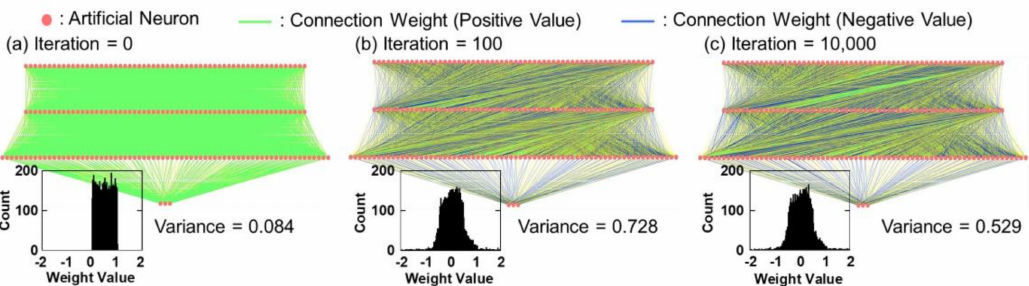
Figure 7. Neural interpretation diagram of TDNN model ( a ) before iteration and then after ( b ) 100 and ( c ) 10,000 iterative computations. The insets illustrate weight distribution of TDNN